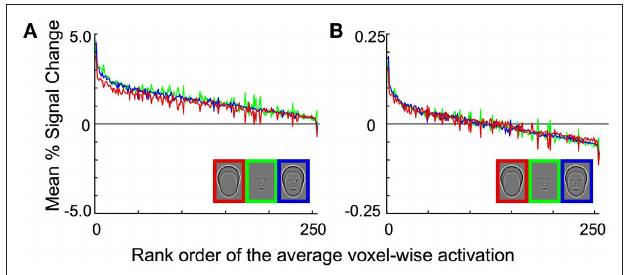
Figure 2 | experiment 1 average BOLD activation pre- and post-normalization in the combined OFA and FFA region of interest. (A) The activation within each voxel to the three categories, rank ordered based on the percent signal change after averaging across all categories on a voxel-by-voxel basis. Note that the response to the head outlines (red curve) is consistently lower than the response to the other two categories. (B) The activation within each voxel to the three categories, after normalization. Note that there are no longer differences in the mean level of activation across the three stimulus categories. However, differences in the pattern of activation across categories may still remain, which could provide the information necessary for reliable pattern